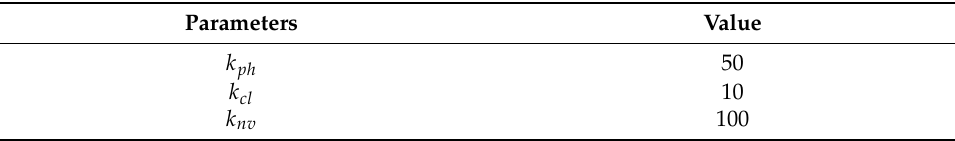
Table 2. Algorithm parameters of the proposed method.